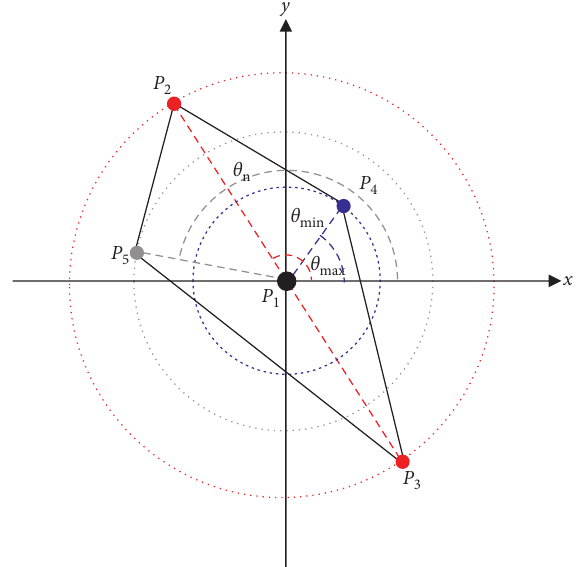
Figure 7: Establishment of single rock.